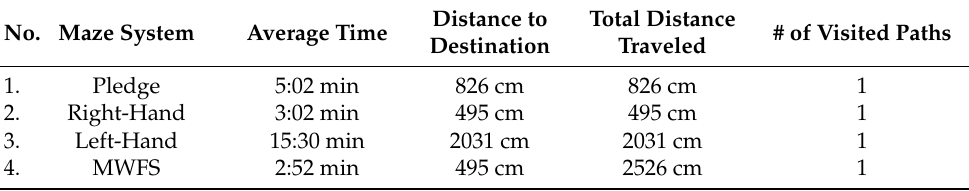
Figure 10. The route of the solver robot using 4 algorithms in testbed # 2. ( A ) Pledge algorithm; ( B ) right-hand algorithm; ( C ) left-hand algorithm; ( D ) MWFS. Table 7. Experimental results obtained from the second experiment testbed.